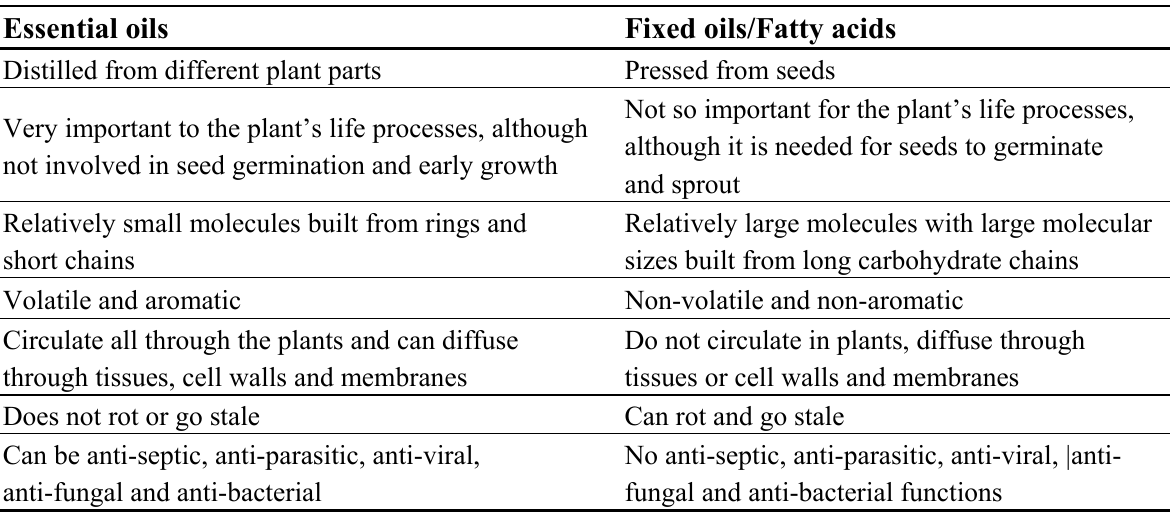
Table 1. Differences between essential and fixed oils